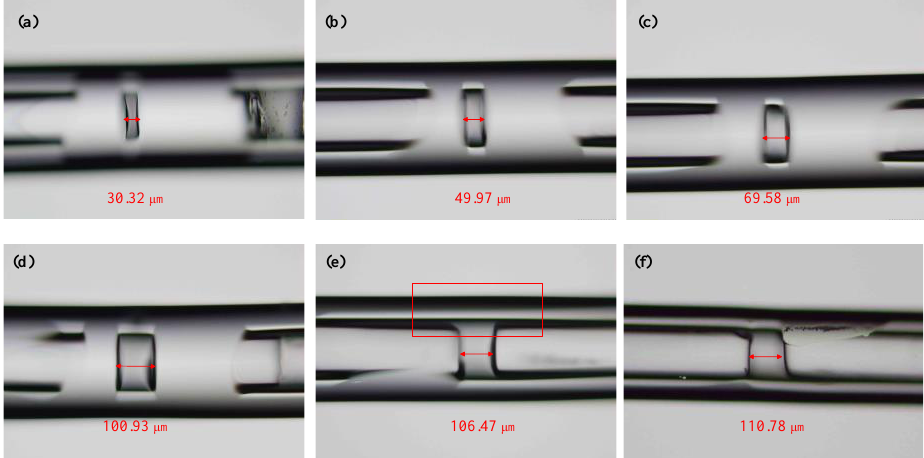
Figure 5. Micrographs of the sensing cavity welded by a CO 2 laser for one time. ( a ) The cavity length was set at 30 µ m; ( b ) 50 µ m; ( c ) 70 µ m; ( d ) 100 µ m; ( e ) 110 µ m with an increase in the welding power of the CO 2 laser; ( f ) 110 µ m with an increase in the welding time of the CO 2